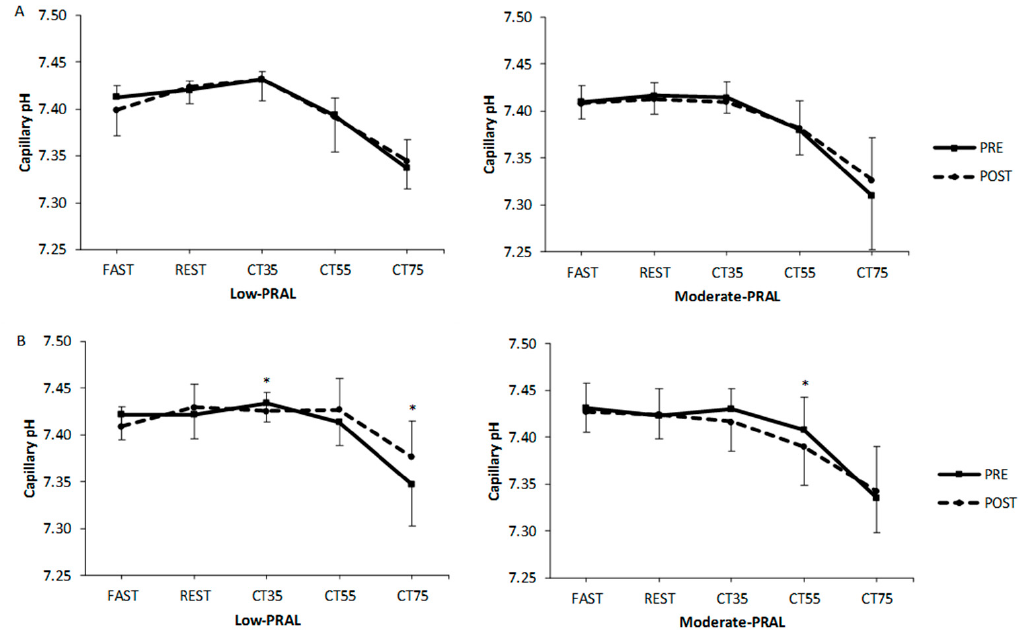
Figure 2. Capillary pH in men ( A ) and women ( B ) before (PRE) and after (POST) the 12-week diet period at rest (FAST, REST) and during submaximal cycling (CT35, CT55, CT75; CT = cycling test). * p < 0.05, statistically significant difference between PRE and POST within a diet group (two-way repeated measures ANOVA, a paired t -test). Values are mean ±